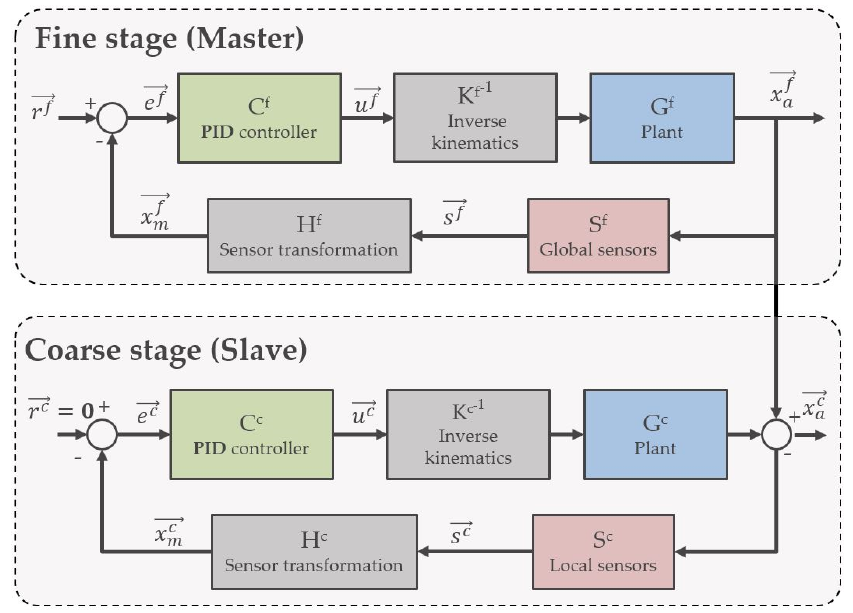
Figure 9. Control block diagram of the master–slave control scheme of the dual servo maglev stage.